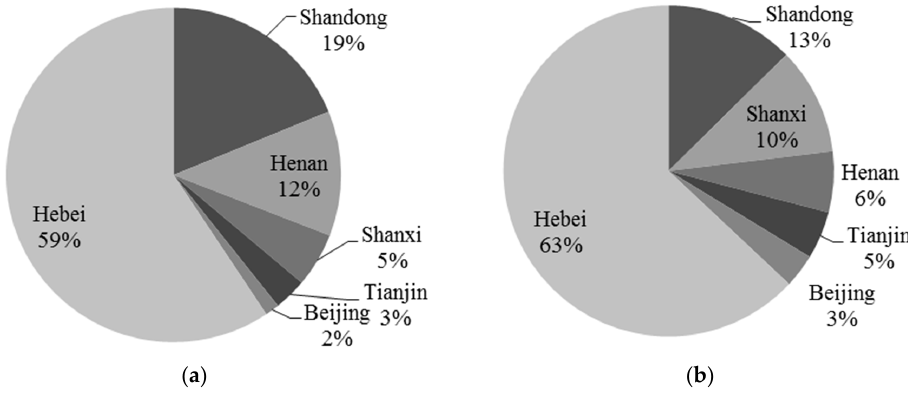
Figure 5. Allocation of WF between administrative districts within the HRB: ( a ) wheat; and ( b ) maize. Table 5. WF for different administrative districts, 2011–2015.